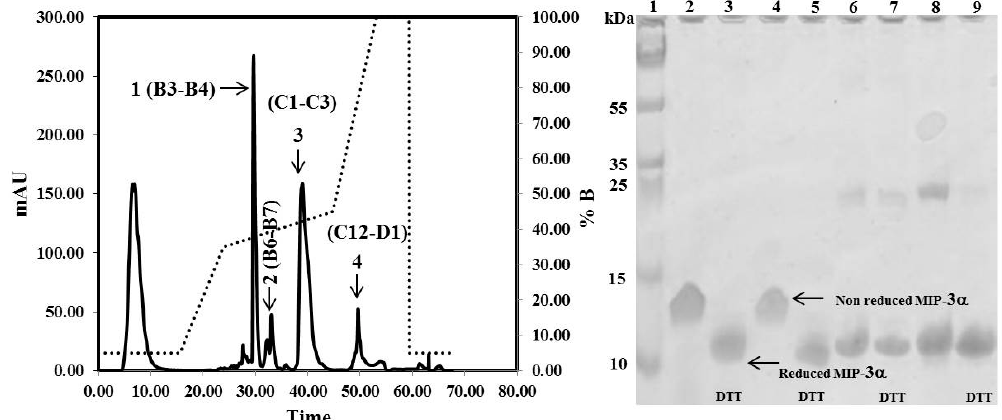
Figure 4. RP-HPLC chromatograms obtained for the purification of MIP-3 α after TEV protease digestion. Indicated by the arrows are the purified MIP-3 α (1), MIP-3 α and cleaved CaM (2), cleaved CaM (3), and the remaining undigested CaM-MIP-3 α construct (4). Solid lines represent the absorbance at 280 nm. The dotted line represents the acetonitrile (buffer B) gradient. SDS-PAGE showing the purification of MIP-3 α . Lanes 2, 4, 6, and 8 shows fraction B3, B4, B6, and B7 respectively. Lanes 3, 5, 7, and 9 shows fraction B3, B4, B6, and B7 respectively, were incubated with 10 mM DTT at 37 ° C for 1 hr before SDS-PAGE analysis.